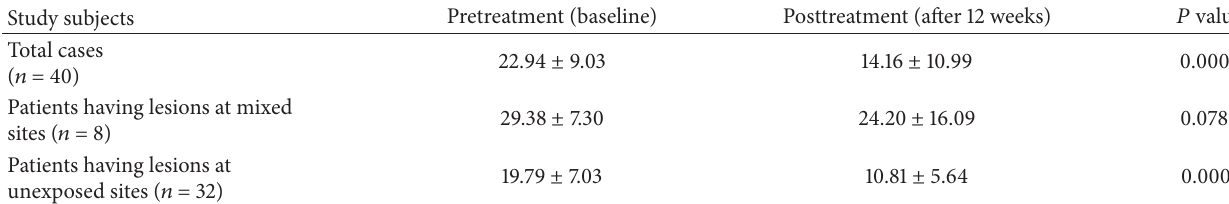
Table 2: PASI scores in study group at baseline and after 12 weeks of regular treatment.